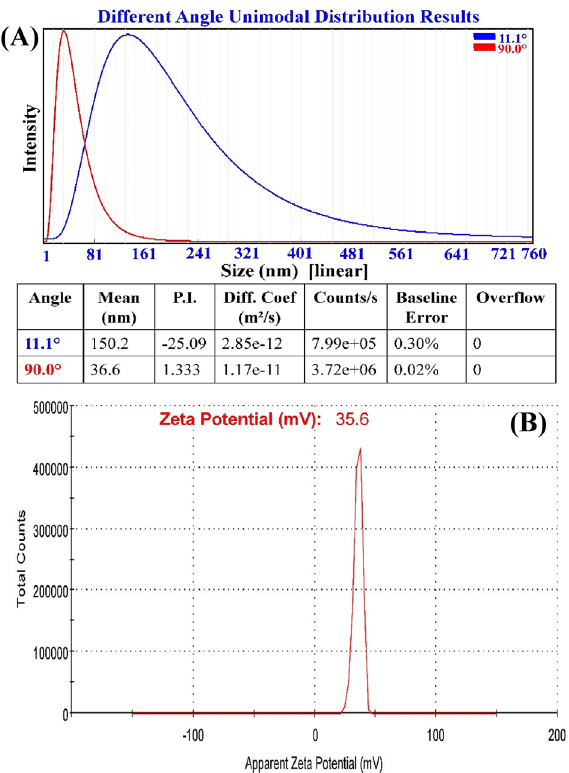
Figure 6. Analyses of chitosan nanoparticles with ( A ) PSA and ( B ) ζ-potential for bio-synthesized with Streptomyces microflavus strain